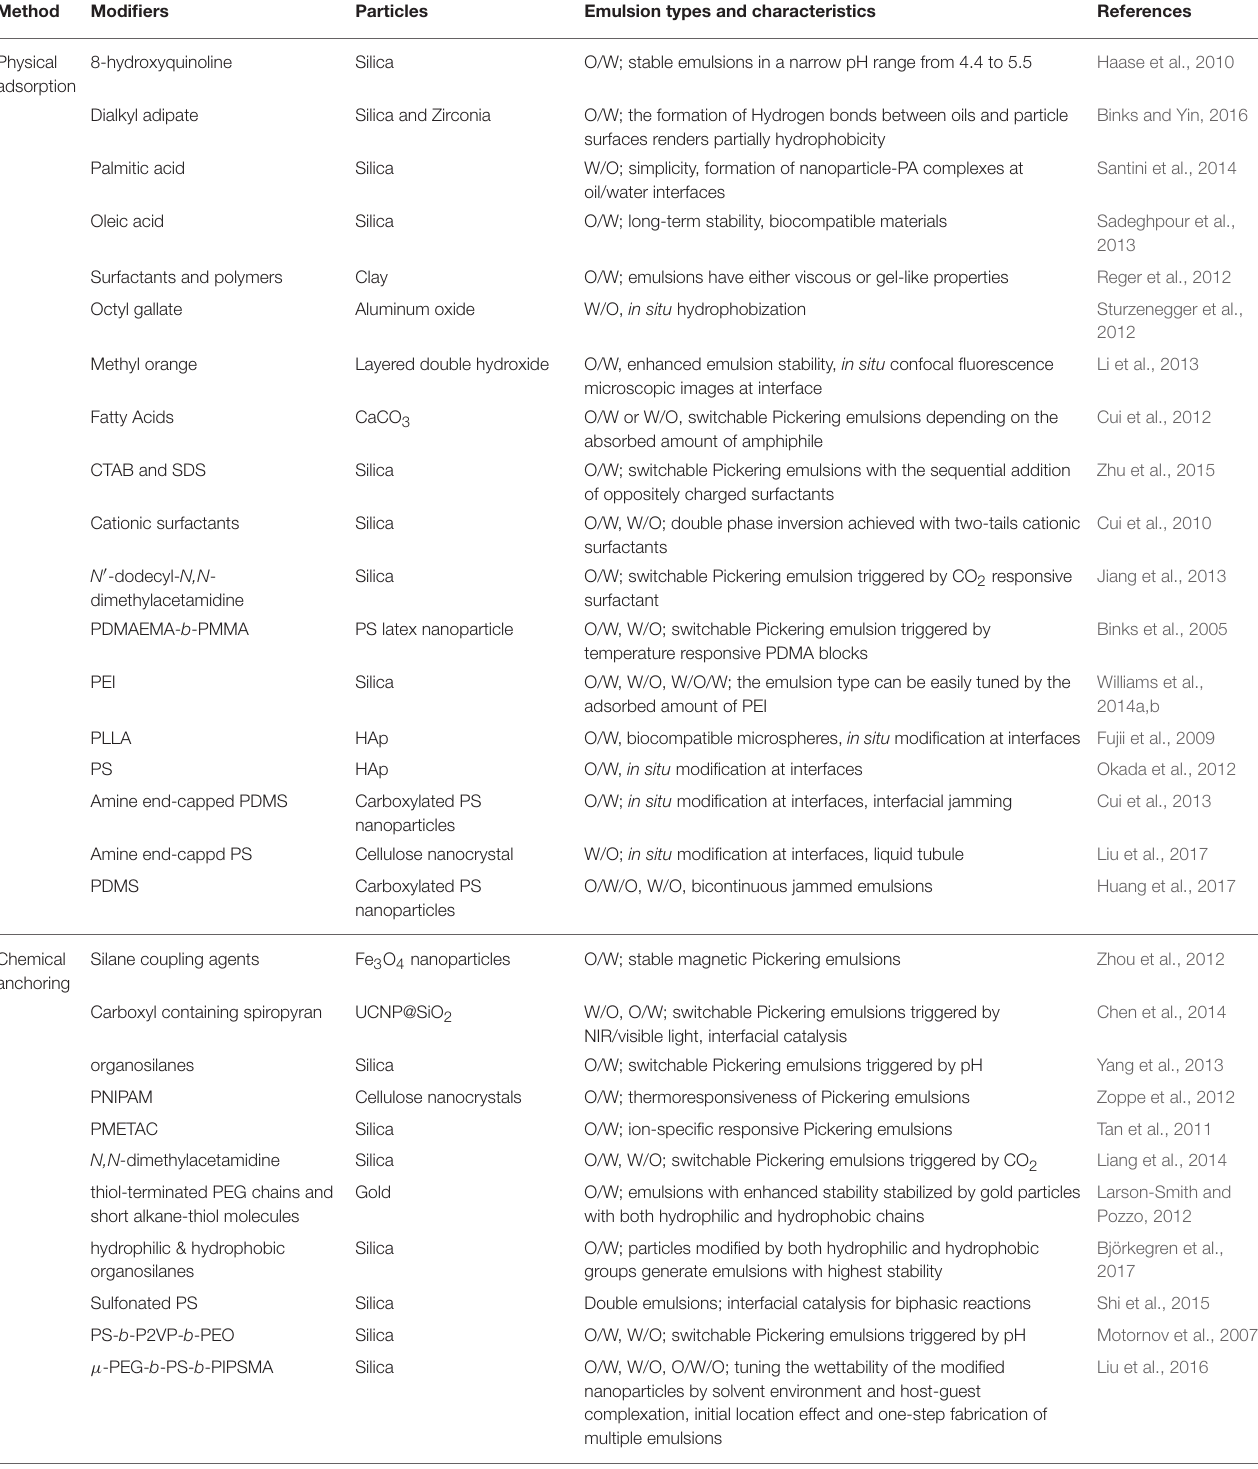
TABLE 1 | Typical fabrication methods of tuning wettability of particles for Pickering